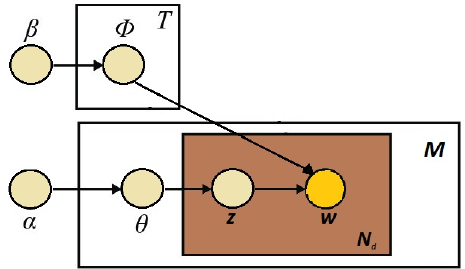
Figure 2. The latent Dirichlet allocation (LDA)